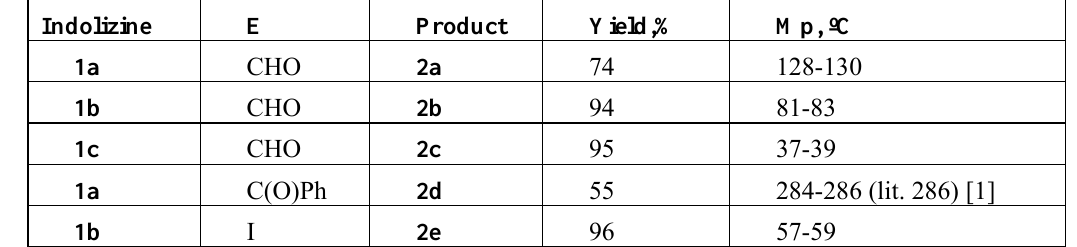
Table 1. Characteristics of 5-Substituted